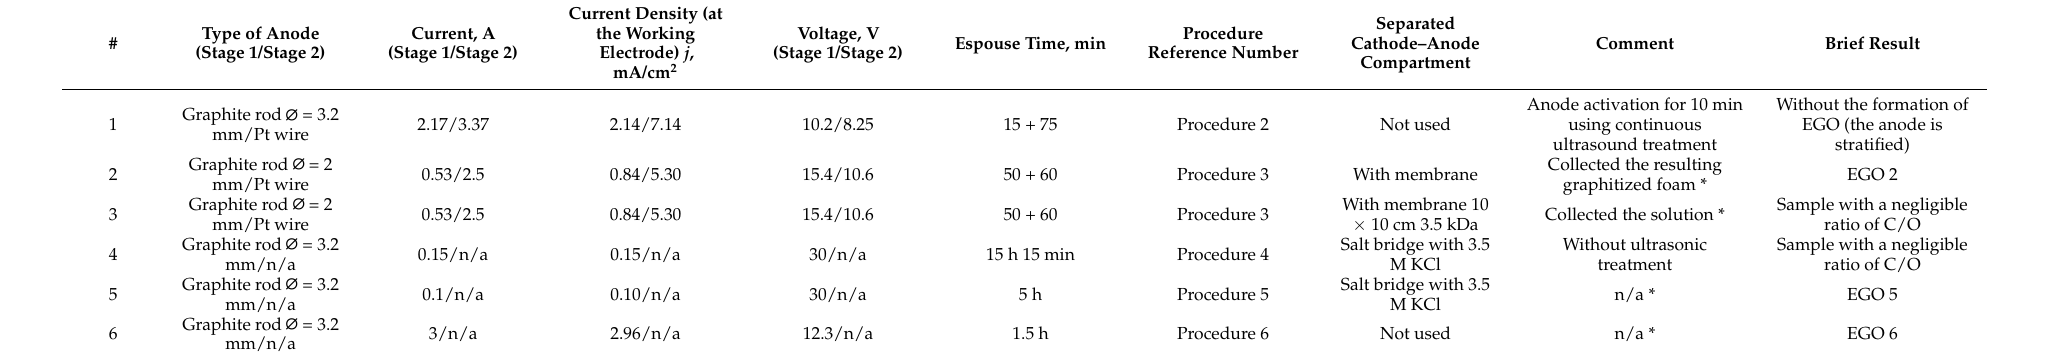
Table 1. Generalized experimental conditions for preparations of graphene oxide (EGO) by ultrasound-assisted (US) anodic exfoliation–oxidation.